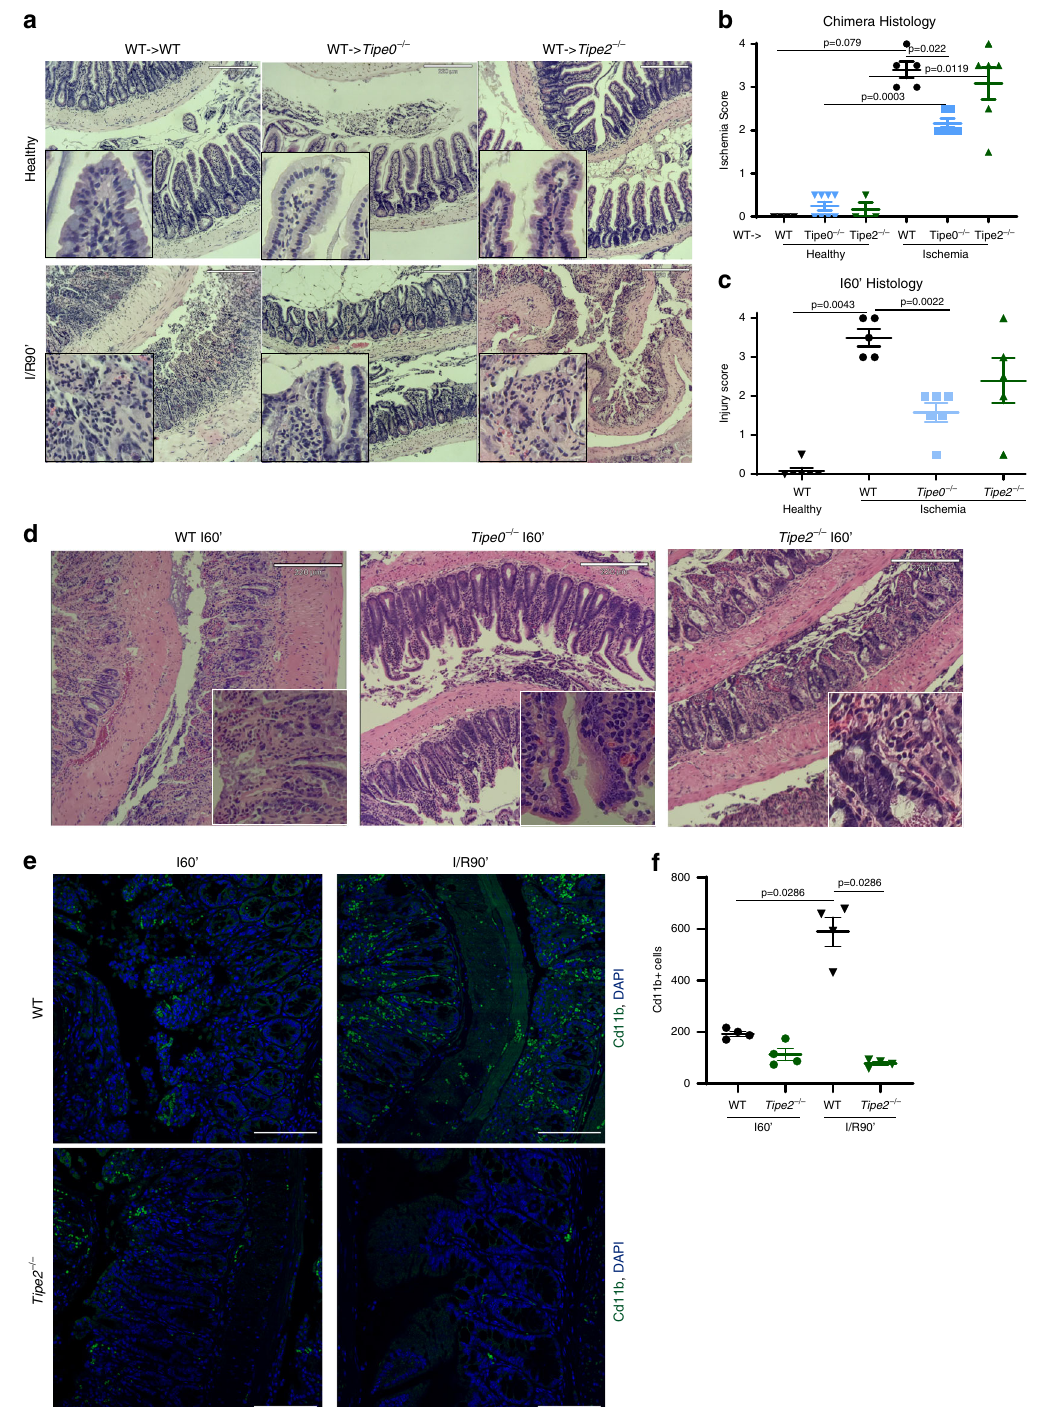
Fig. 2 Protection from intestinal ischemia/reperfusion injury due to Tipe0 gene deletion is immune-cell independent and occurs during the ischemic phase of injury in contrast to Tipe2 gene deletion. a , b Histology from bone marrow chimeras subjected to I/R90 ′ , along with adjacent healthy tissue controls. Bars = 220 µ m, inserts are 4× magni fi ed, with blinded histology scores ( b ); Number of mice/group as follows: WT- > WT healthy = 4, WT-> Tipe0 − / − healthy = 8, WT- > Tipe2 − / − healthy = 3, WT- > WT ischemia = 5, WT-> Tipe0 − / − ischemia = 6, WT- > Tipe2 − / − ischemia = 6; images represent the mean histological score of each group. c Blinded histology scores and d representative images of mice subjected to 60 min of ischemia with no reperfusion time (I60 ′ ). N = 5 mice/group except WT Healthy and Tipe0 − / − I/R60 ′ , where N = 6; images represent the mean histological score, bars = 220 µ m, inserts are 4× magni fi ed. e , f CD11b staining (green) of WT and Tipe2 − / − mice subjected to I60 ′ and I/R90 ′ , image representative of 4/4 mice/ group; bars = 100 µ m; quanti fi cation in f . For all panels: p as indicated in the fi gure. For all graphs, error bars are mean ± SEM. Multiple group comparisons were by Kruskal – Wallis one-way ANOVA. Two-tailed Mann – Whitney U test was used to con fi rm ANOVA fi ndings. Source data are provided as a source data fi